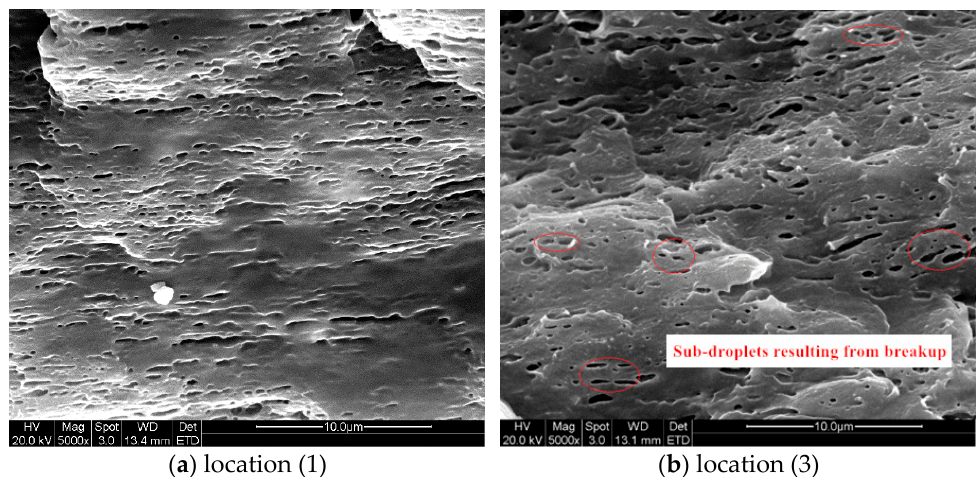
Figure 16. SEM images of the droplets in shear layer of case III part.